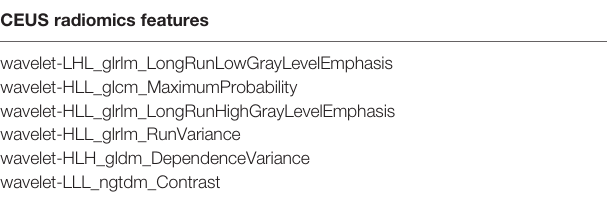
TABLE 4 | The CEUS radiomics features. CEUS radiomics features